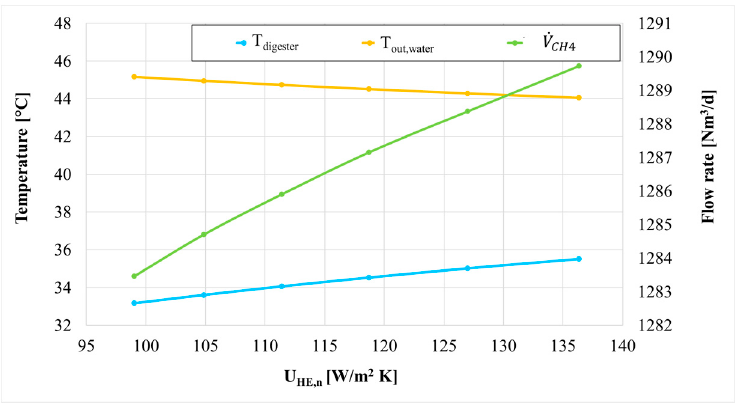
. . . m & m & V CH 4 vs. U H,n for m OFMSW = 0.174 kg / s, m water = 0.557 kg / s and T in,water = = 0.174 kg/s, water = 0.557 kg/s and T in,water = 55 °C